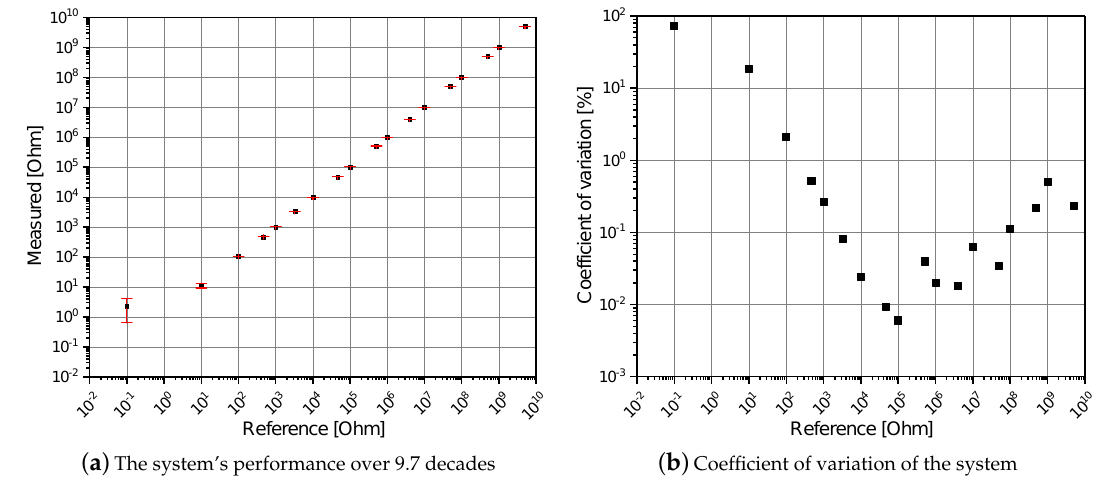
Figure 6. System performance over an input range of 9.7 decades ( a ) and the coefficient of variation for each decade ( b